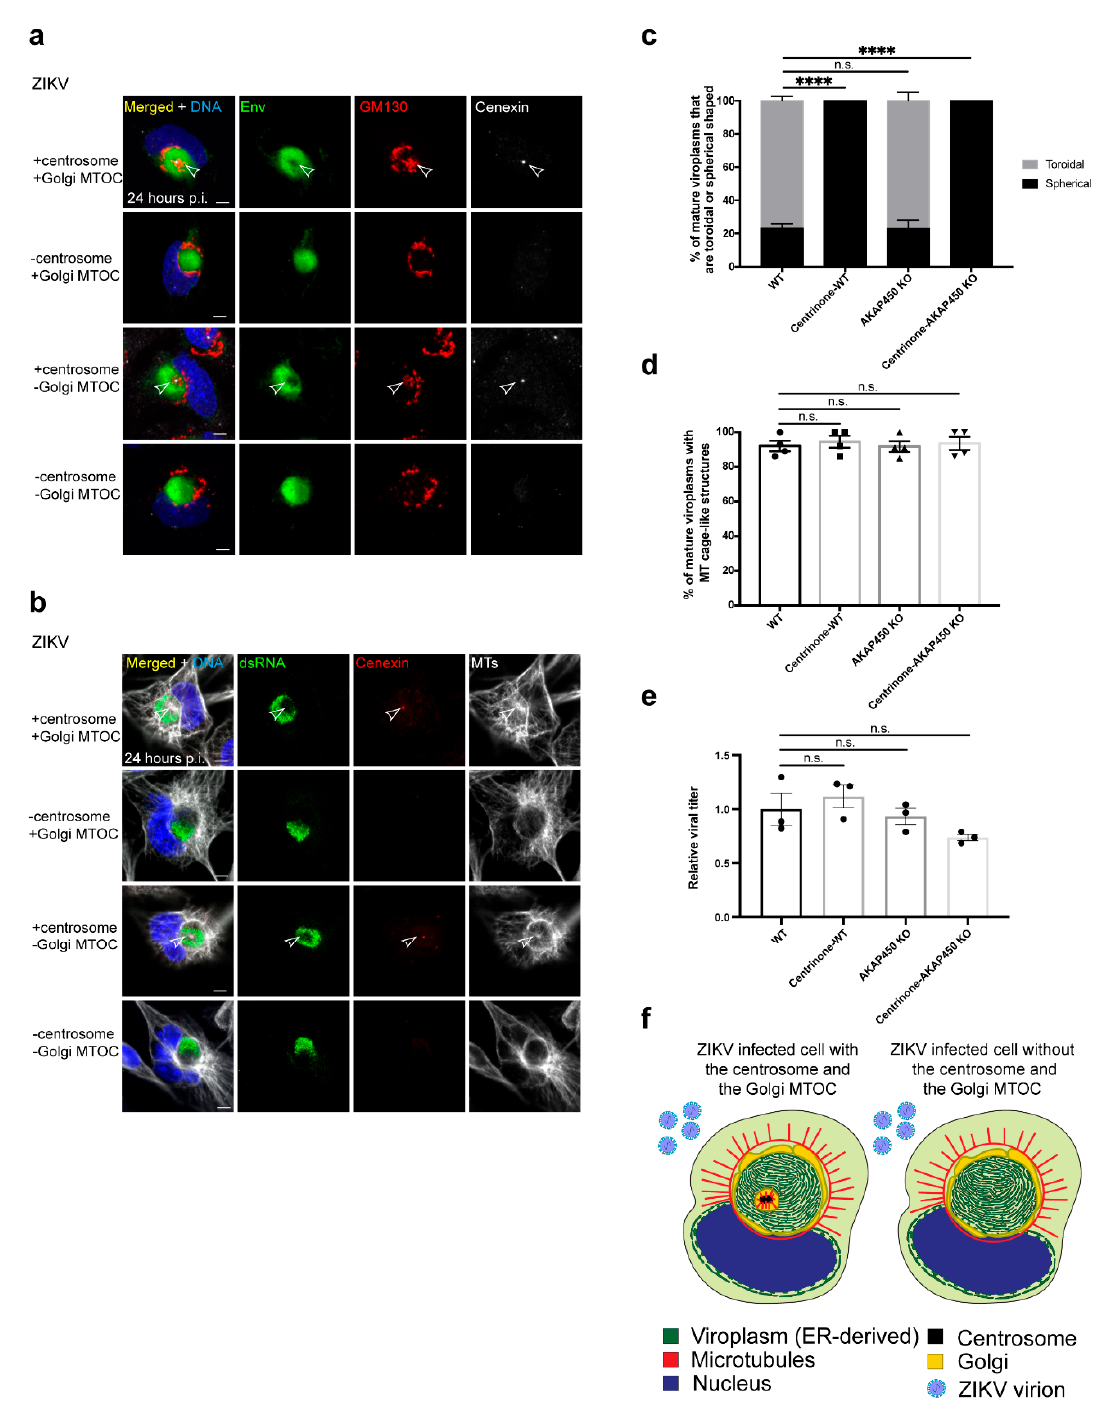
Figure 4. The centrosome and the Golgi MTOCs are not required for ZIKV proliferation ( a , b ) IF staining to show local- ization of Golgi protein GM130 (( a ); red) and MTs (( b ); white) of WT (+centrosome/+Golgi MTOC), centrinone-treated WT (-centrosome/+Golgi MTOC), AKAP450 KO (+centrosome/-Golgi MTOC), and centrinone-treated AKAP450 KO (-centrosome/-Golgi MTOC) ZIKV (MR766) infected SNB19 cells 24 h p.i. Viroplasms are marked by Env (( a ); green) or dsRNA (( b ); green). Centriolar protein cenexin (( a ); white, ( b ); red) marks the centrosome, and fainter puncta are nonspecific signals. Arrowheads point to the centrosome and the Golgi ( a ) or MTs ( b ) at the core; ( c ) quantification of mature viroplasms that are toroidal or spherical-shaped in ZIKV-infected WT, centrinone-treated WT, AKAP450 KO, and centrinone-treated AKAP450 KO cells. T-tests comparing the frequency mature viroplasms that are spherical-shaped for the following conditions from four independent experiments (5–18 infected cells/experiment), infected: WT vs. centrinone-treated